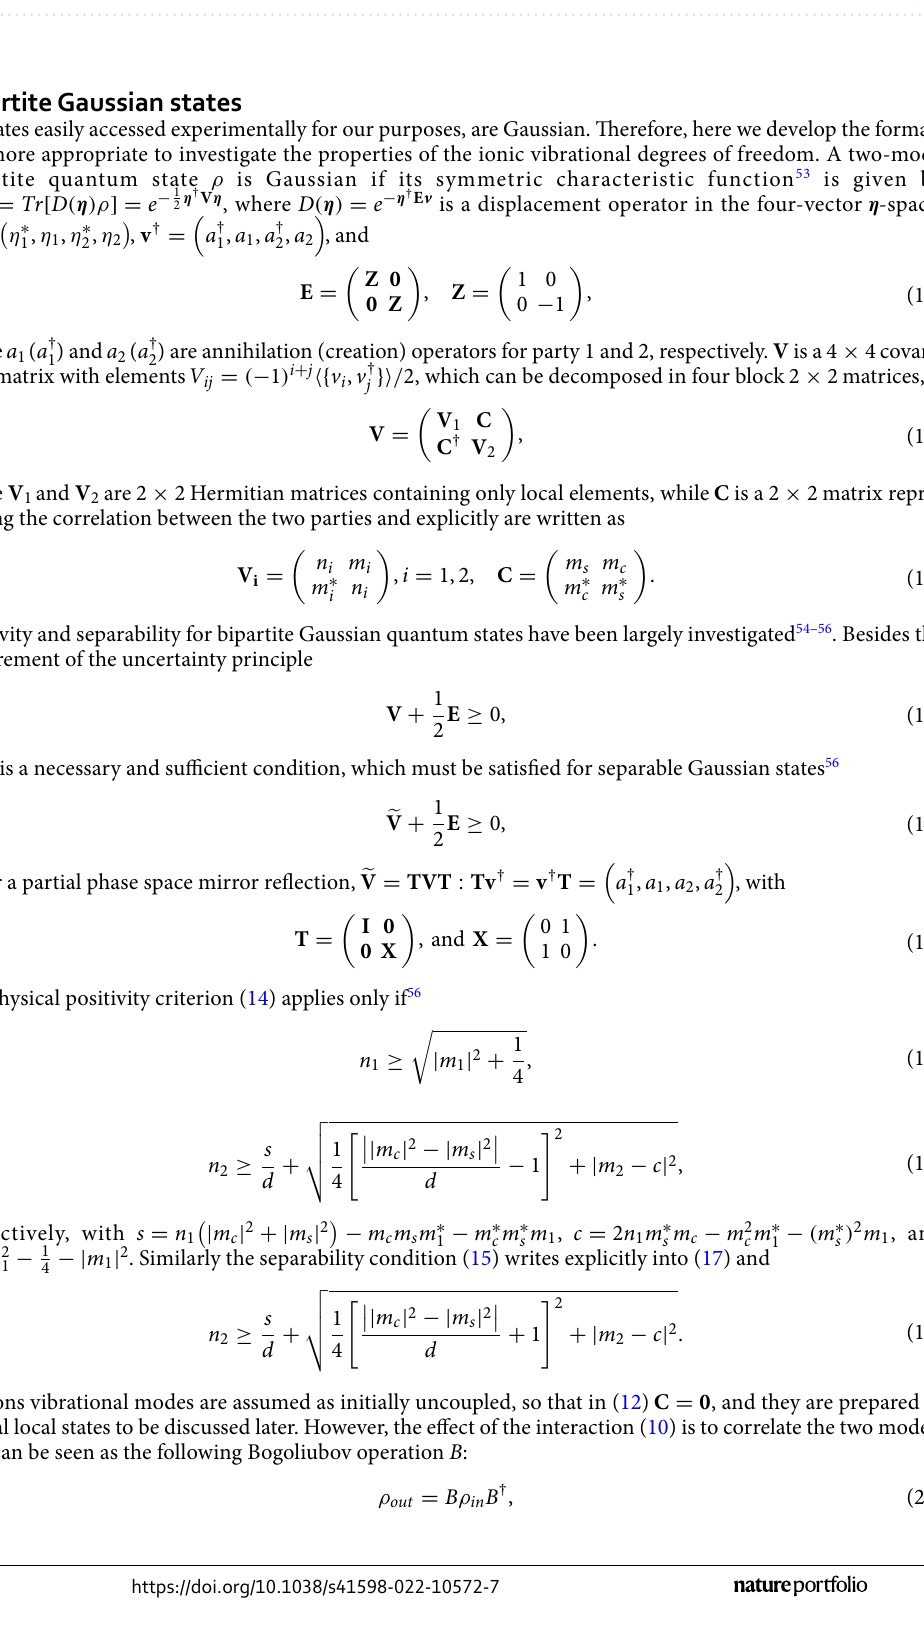
Table 1. Parameter used along this article, following experimental values employed in Ref. 37 . From left to right: (cid:31) is the ion vibrational angular frequency, d is the mean distance between ions, g is the ions coupling constant, T is the temperature with respective thermal average number ¯ n inside parenthesis, and Ŵ is the heating rate due to surface-electrode